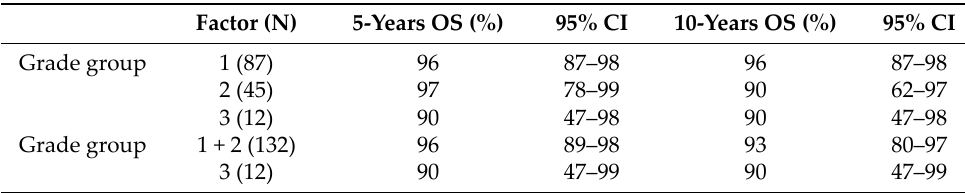
Table 5. OS Rates Stratified by Histologic Grade Group.